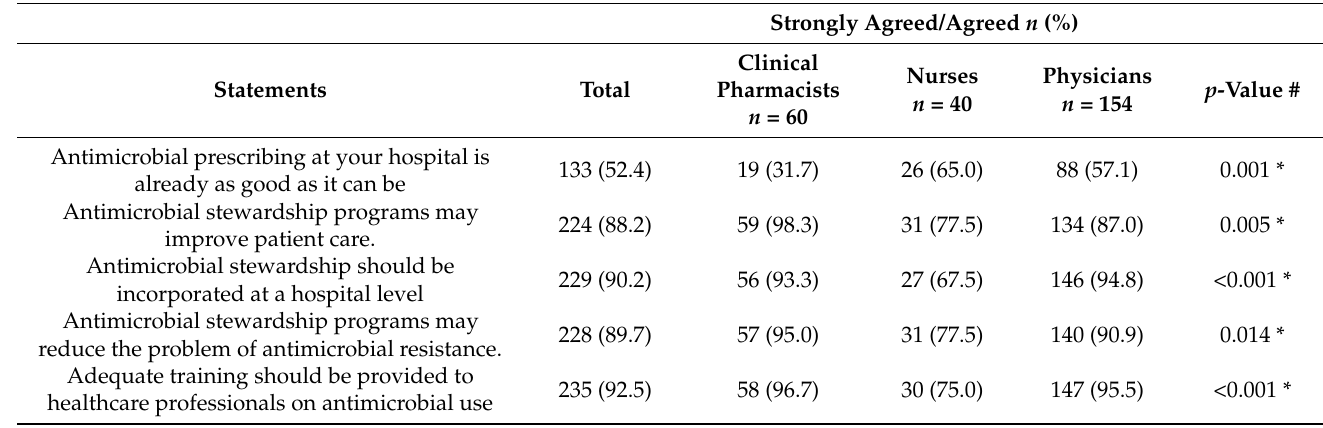
Table 3. Perception of participants towards antimicrobial stewardship ( n = 254). Strongly Agreed/Agreed n